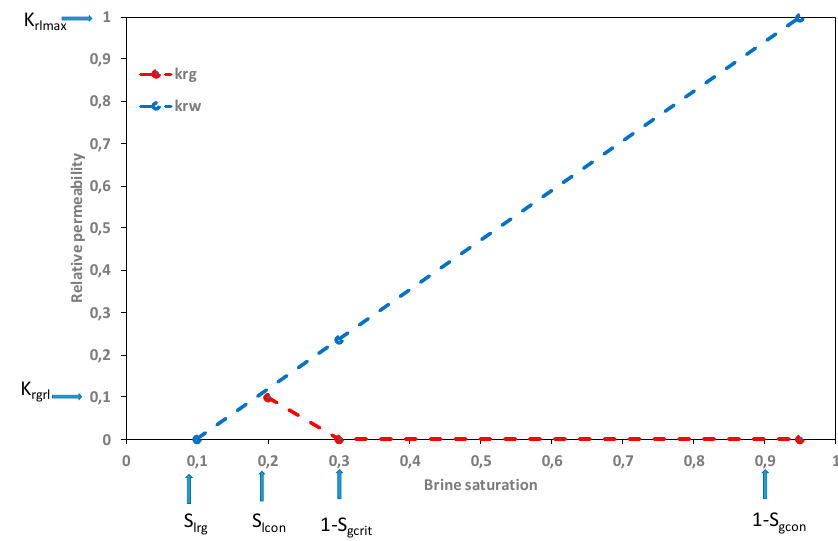
Figure 9. The CO 2 and brine relative permeability in the fracture and endpoints used at the start of the history matching (Le Gallo et al. [19]).